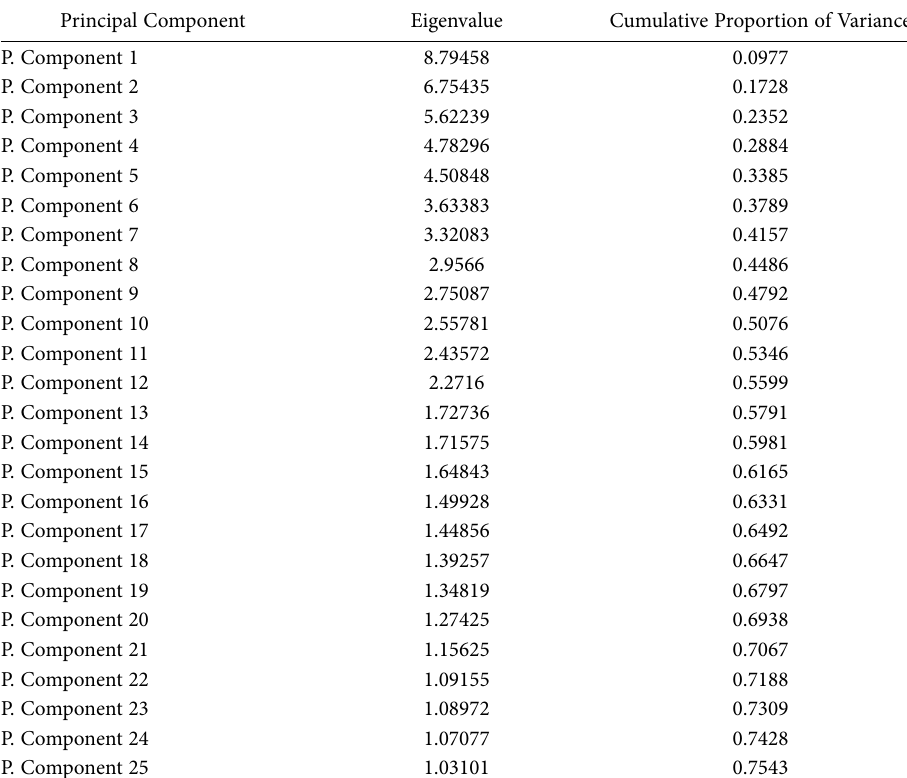
Table A2. Principal Component